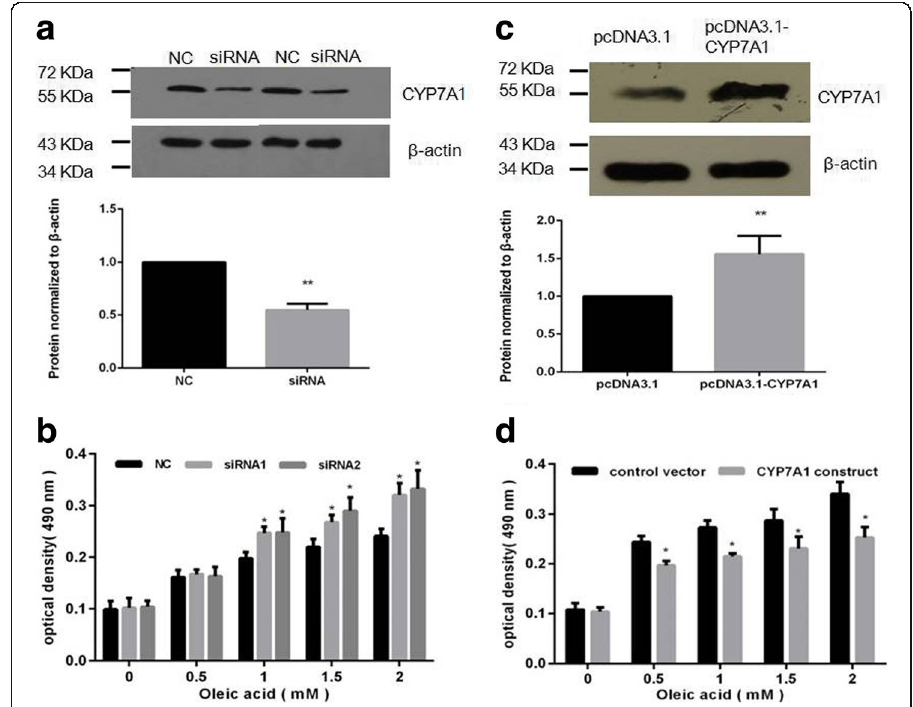
Fig. 4 miR-17-induced steatosis depends on the expression of CYP7A1. a Downregulation of CYP7A1 by siRNA transfection in HepG2 cells. b CYP7A1 siRNA transfection promotes steatosis in HepG2 cells. c Upregulation of CYP7A1 by CYP7A1 expression construct transfection in miR-17 HepG2 cells. d Re-introduction of CYP7A1 into miR-17 HepG2 cells could partially alleviate